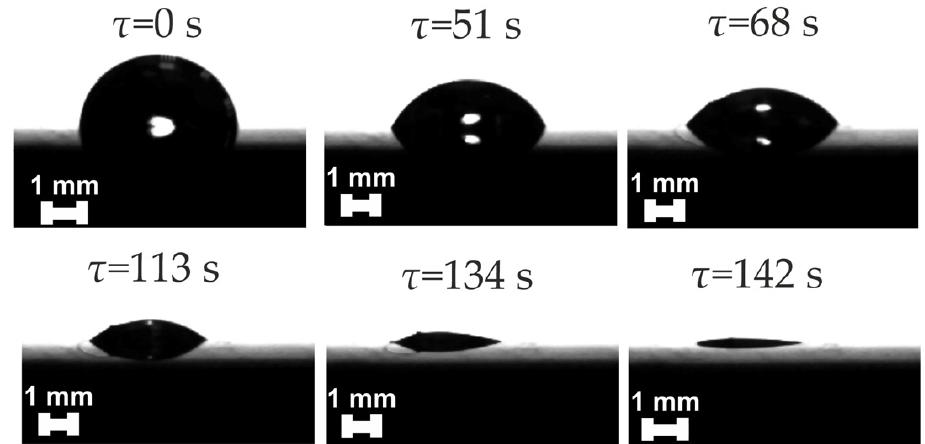
Figure 4. Photo images of water droplet evaporation when the three-phase contact line moves uniformly during the transition from the CCD to the mixed stage on St 1.0 surface.